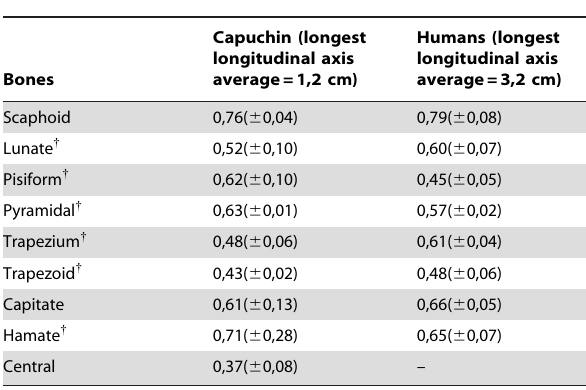
Table 1. Ratio (plus standard deviation) between carpal bones and carpus in capuchin and human ( { significant difference; Chi-square, p ,